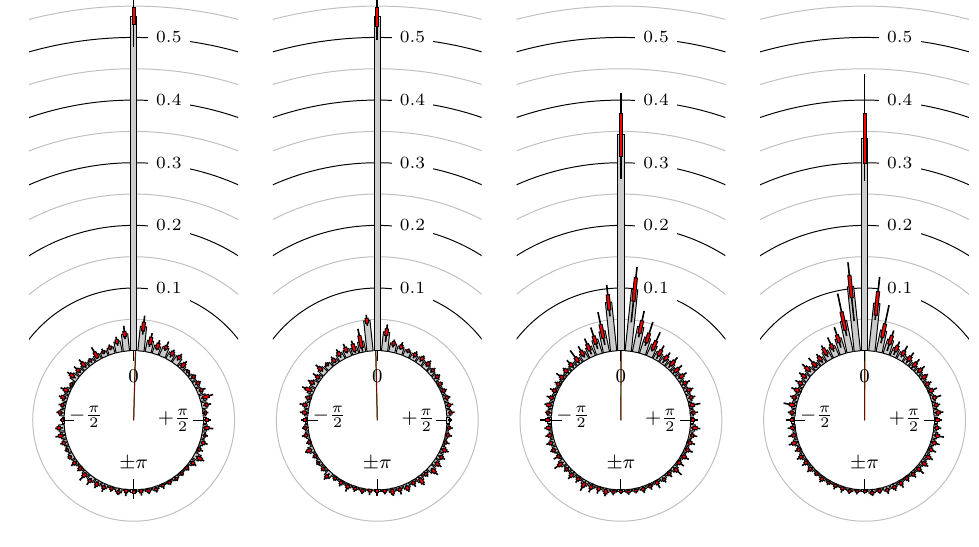
Figure 8. DAX versus EuroSTOXX 50.